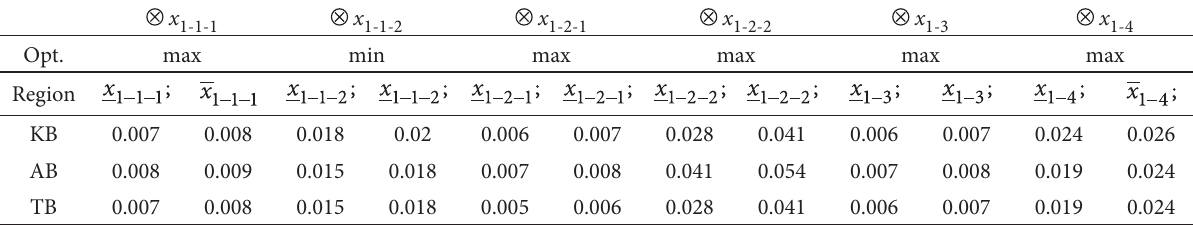
Table 10. Normalized weighted decision making